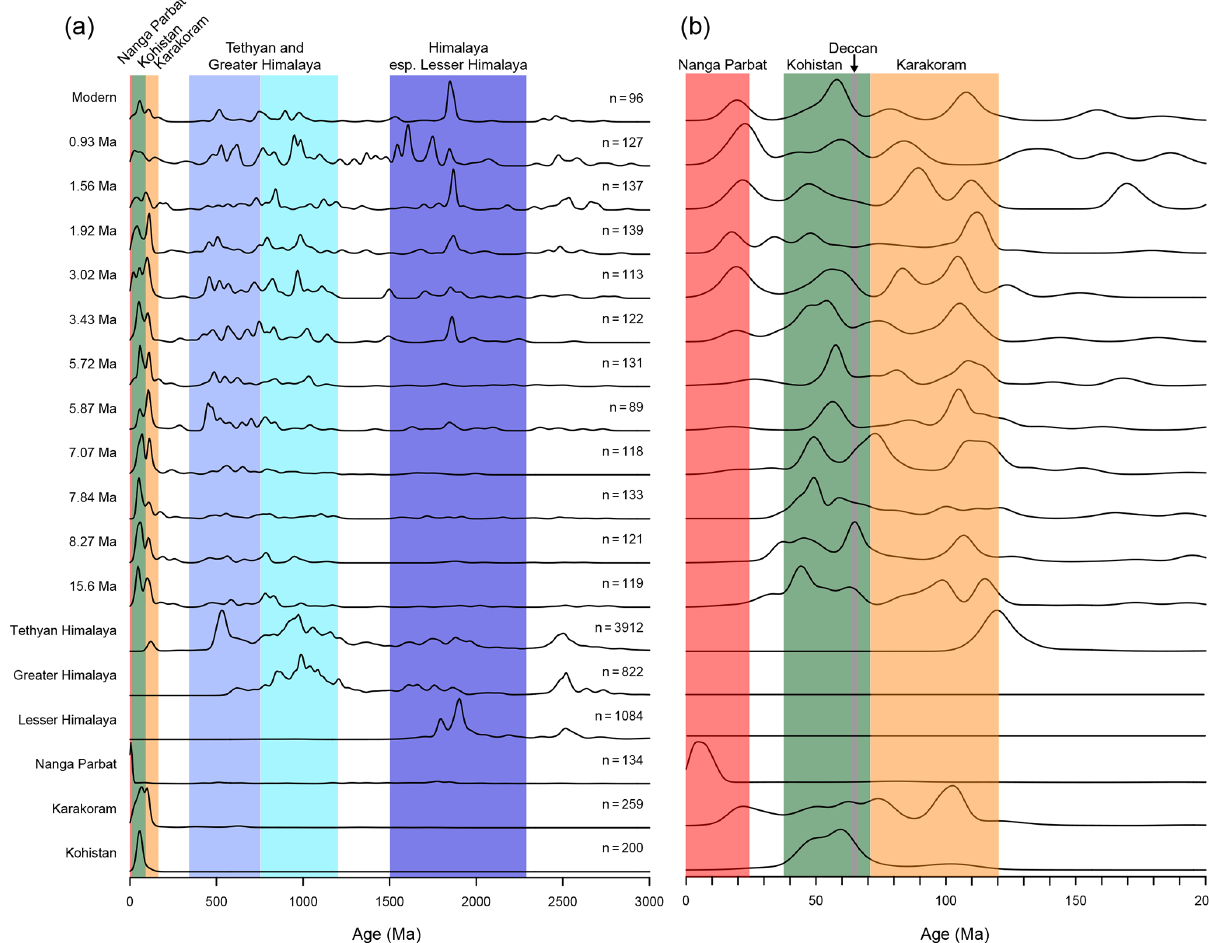
Figure 6. Kernel density estimate (KDE) plots for the zircon U–Pb ages from Laxmi Basin compared with some of the major source terrains in the Western Himalaya, from the compilation of Alizai et al. (2011). Colored strips depict characteristic age peaks that can be linked to specific source areas within the Western Himalaya. Left column shows KDE plots to 3000Ma and the right-hand column shows the data from